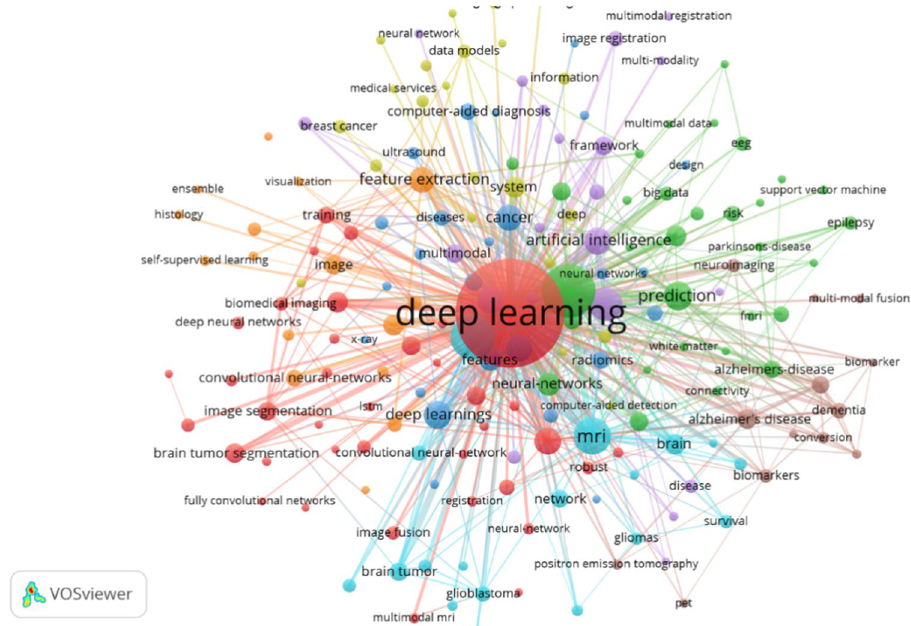
Fig. 7 Keyword co-occurrence network of MMDLM-related